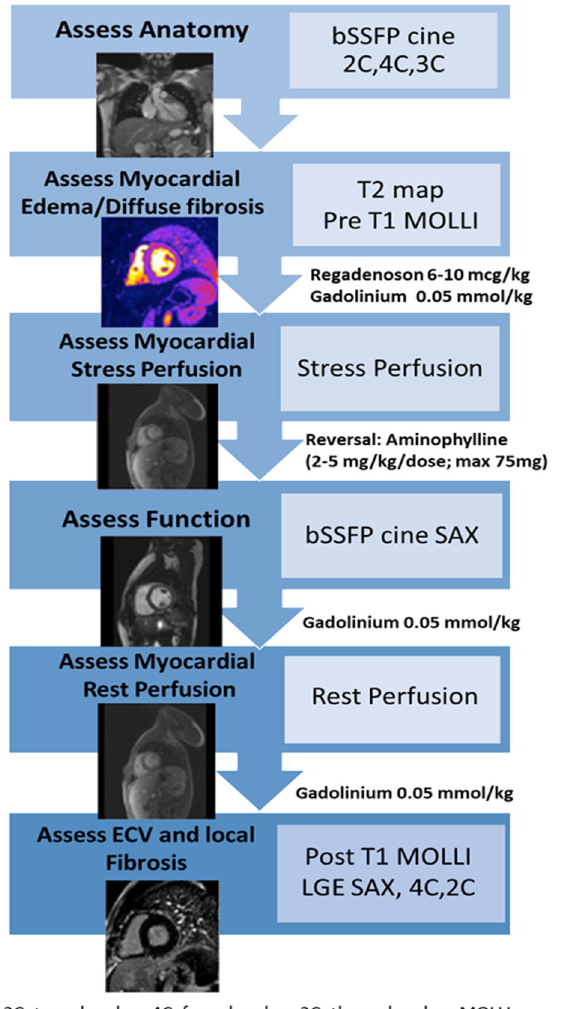
Figure 1. Stress Perfusion MRI Protocol.